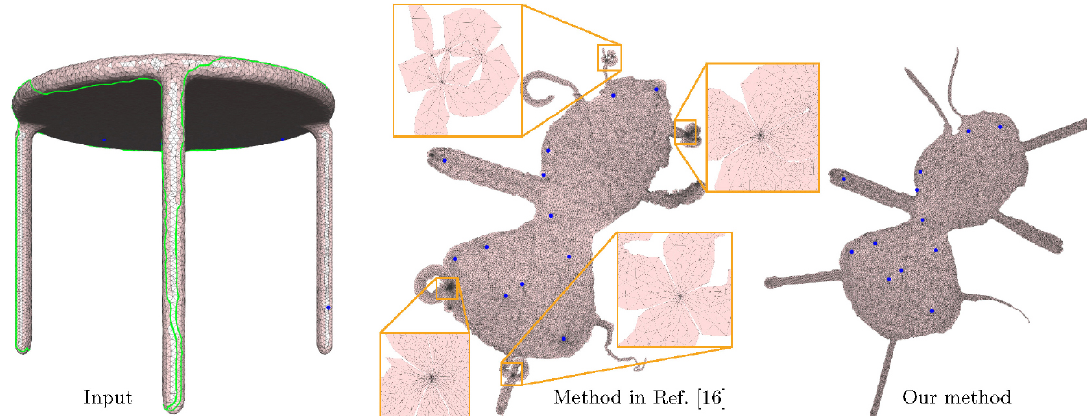
Fig. 1 For the Desk model, the method of Ref. [16] fails to generate a globally injective parameterization which satisfies the positional constraints (blue dots), whereas our method succeeds. Green lines indicate boundary edges of the input model.